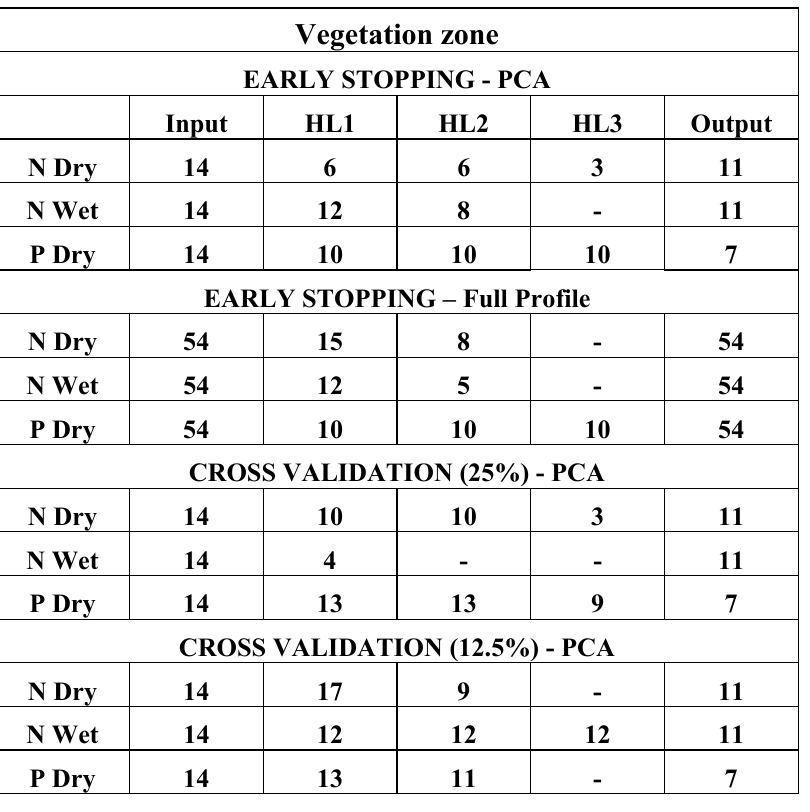
Table 2. Best neural network topologies over vegetation zone obtained for each neural network approach: input, HL1, HL2, HL3 and output columns report the number of neurons for the input, hidden layer 1, hidden layer 2, hidden layer 3 and output, respectively. Each approach employs 3 neural networks, named N Dry (for dry refractivity estimation), N Wet (for wet refractivity estimation) and P Dry (for dry pressure